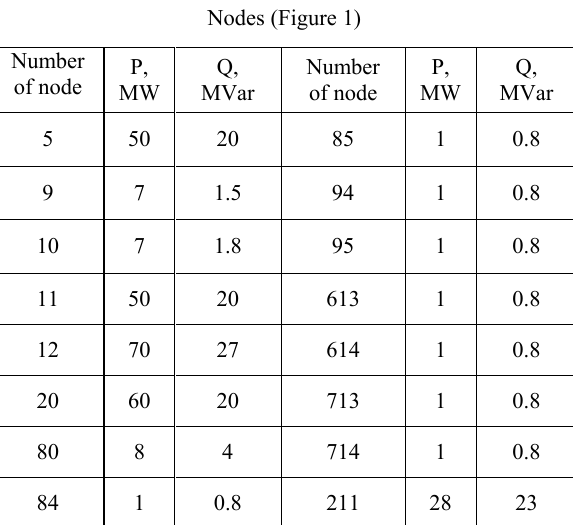
Fig. 1 . Test power system Table 1. Main parameters of synchronous generators